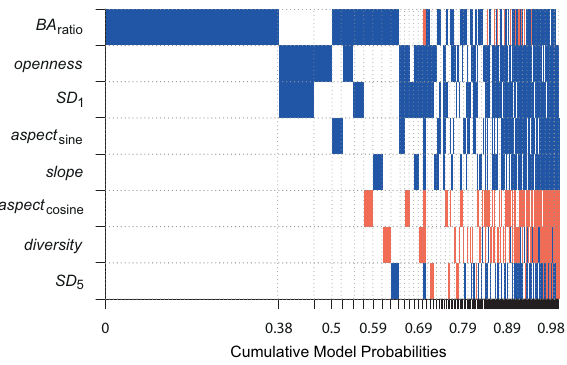
Fig. 4. Relative throughfall as predicted with the simple linear re- gression model that uses BA ratio as predictor for (a) four age classes and (b) the 95 SFD plots in the ASP study area. The credible inter- val for the mature forest’s mean relative throughfall is based on this study’s mature forest throughfall data as well as prior information derived from previous studies in tropical lowland rainforests (e.g., Asdak et al., 1998; Cuartas et al., 2007; Hutjes et al., 1990; Vern- immen et al., 2007). Note that a (1- α ) × 100% Bayesian credible interval is defined as an interval that has a posterior probability of 1- α of containing the parameter of interest, in our case the mean (Bolstad, 2007). We set α to